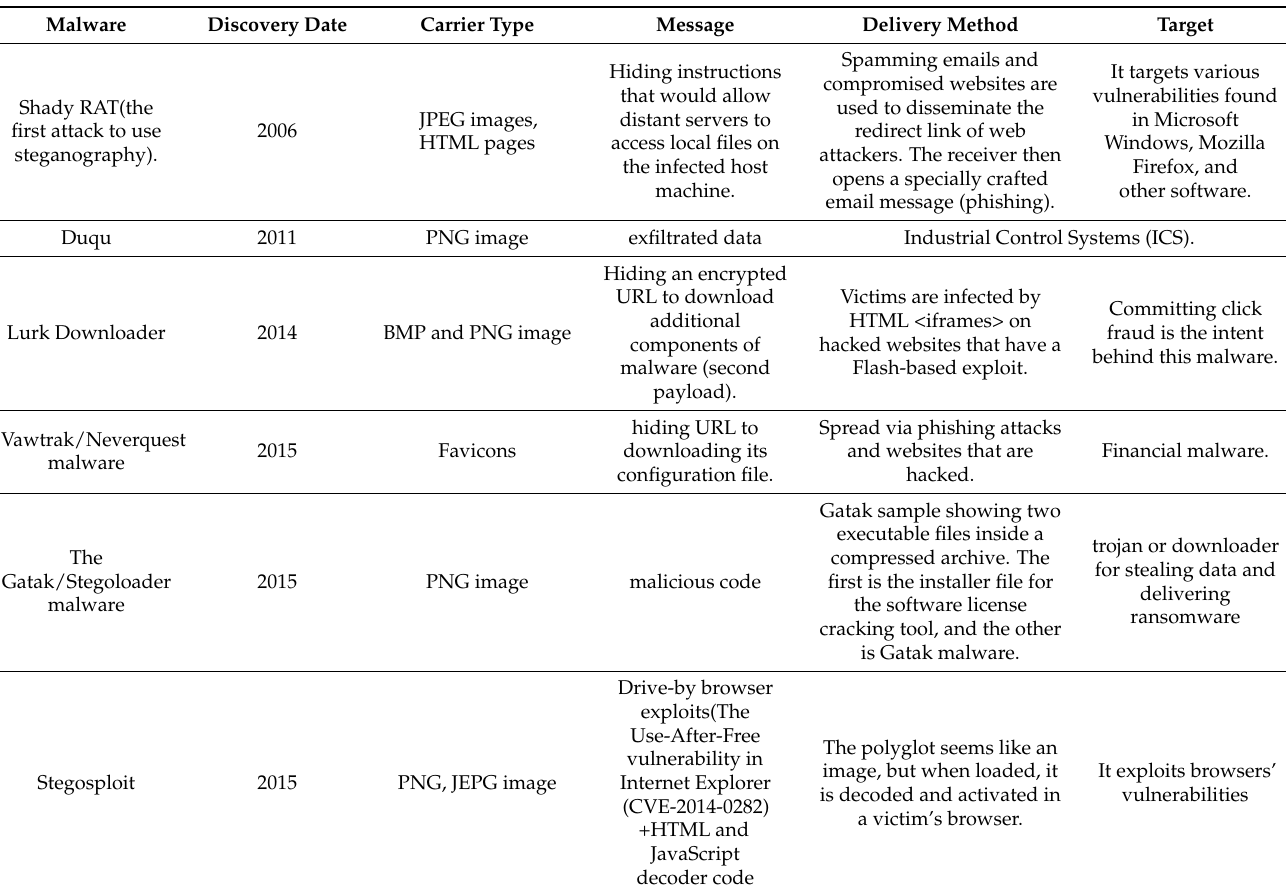
Table A1. Most recent attacks using the